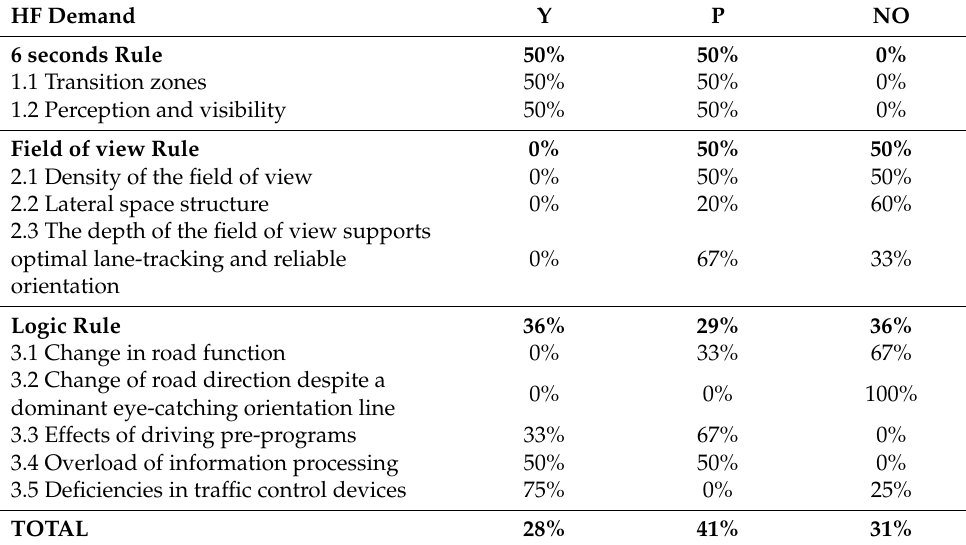
Table 16. HF demand fulfillment of the Italian design